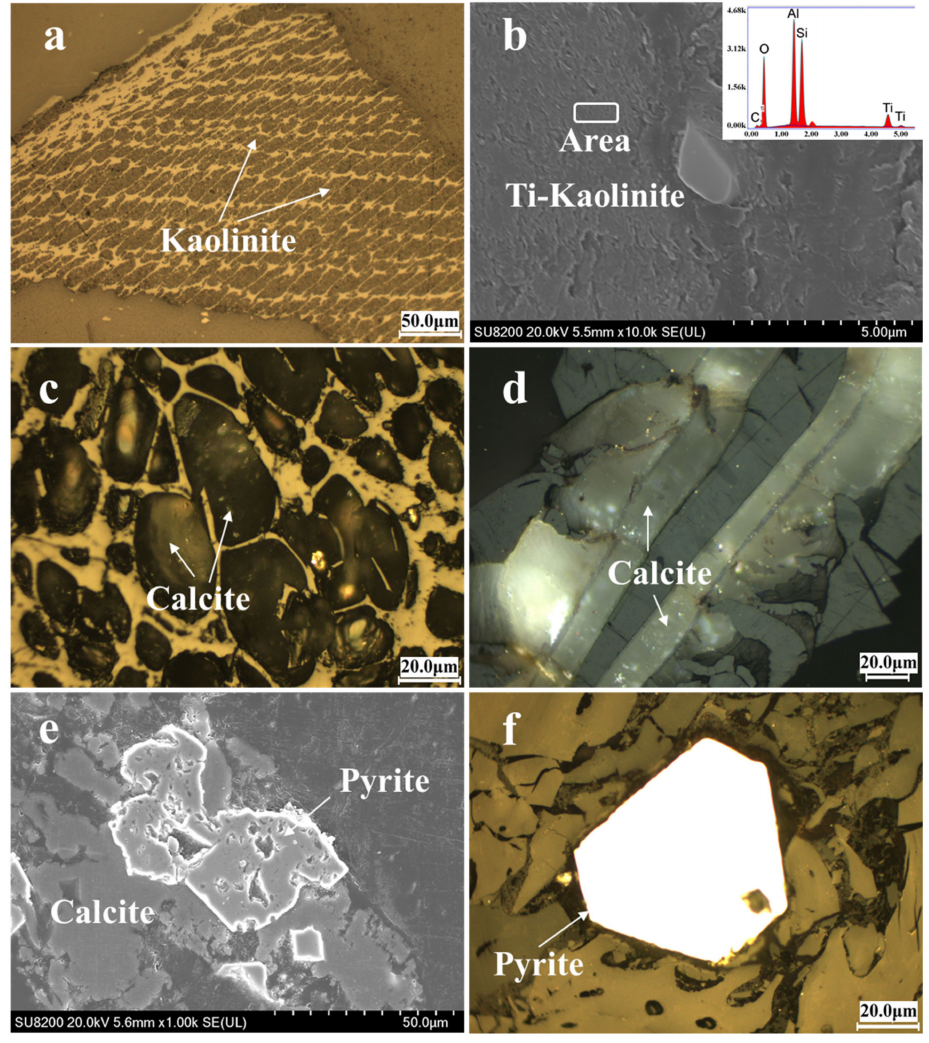
Figure 4. Distribution of the main minerals in the No. 5 coals from the Wujiawan mine, Datong coalfield. ( a ) Cell-filling kaolinite (reflected light); ( b ) fragmental Ti-bearing kaolinite and laminated kaolinite (secondary electron excitation); ( c ) cell-filling calcite (reflected light, oil immersion); ( d ) fracture-filling calcite (reflected light, oil immersion); ( e ) pyrite co- occurred with calcite (secondary electron excitation); and ( f ) pyrite crystal (reflected light, oil